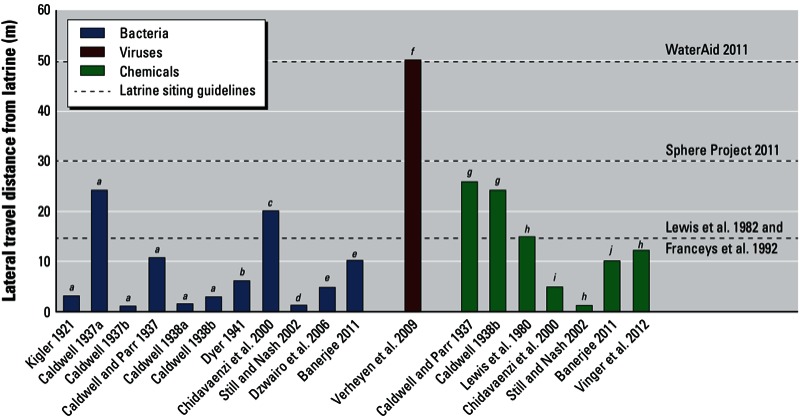
Lateral travel distances of different contaminants emanating from pit latrines in relation to select latrine/water-point siting guidelines. Verheyen et al. (2009) and Vinger et al. (2012) used existing wells to approximate distances, whereas all other studies used test wells to measure distances.
aB. coli; btotal coliforms; ccoliforms; dfecal coliforms; etotal and fecal coliforms; fadenovirus and rotavirus; gchemical stream (nitrate, nitrite, and chloride); hnitrate; initrogen; jsalt tracer.